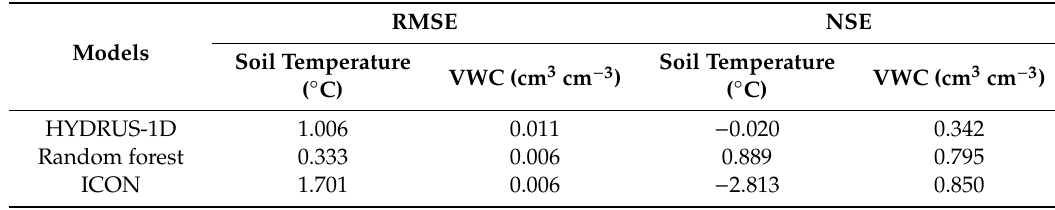
Figure 13. Prediction results from the outdoor air temperature of the weather forecast by ( a , b ) HYDRUS-1D with the measured parameters, ( c , d ) the random forest model via the training data, and ( e – h ) ICON model re-established with four factors in basket No. 13 for ( a , c , g ) soil temperature and ( b , d , h ) volumetric water content. Table 4. RMSEs and NSEs of model